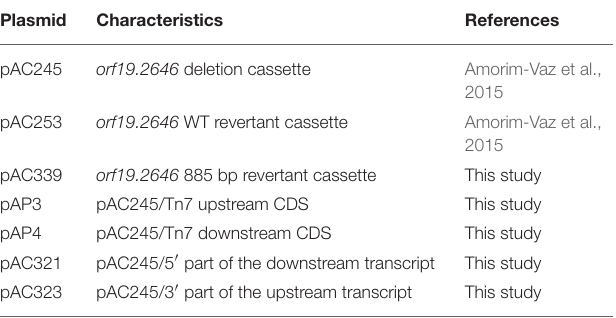
TABLE 2 | List of plasmids. Plasmid